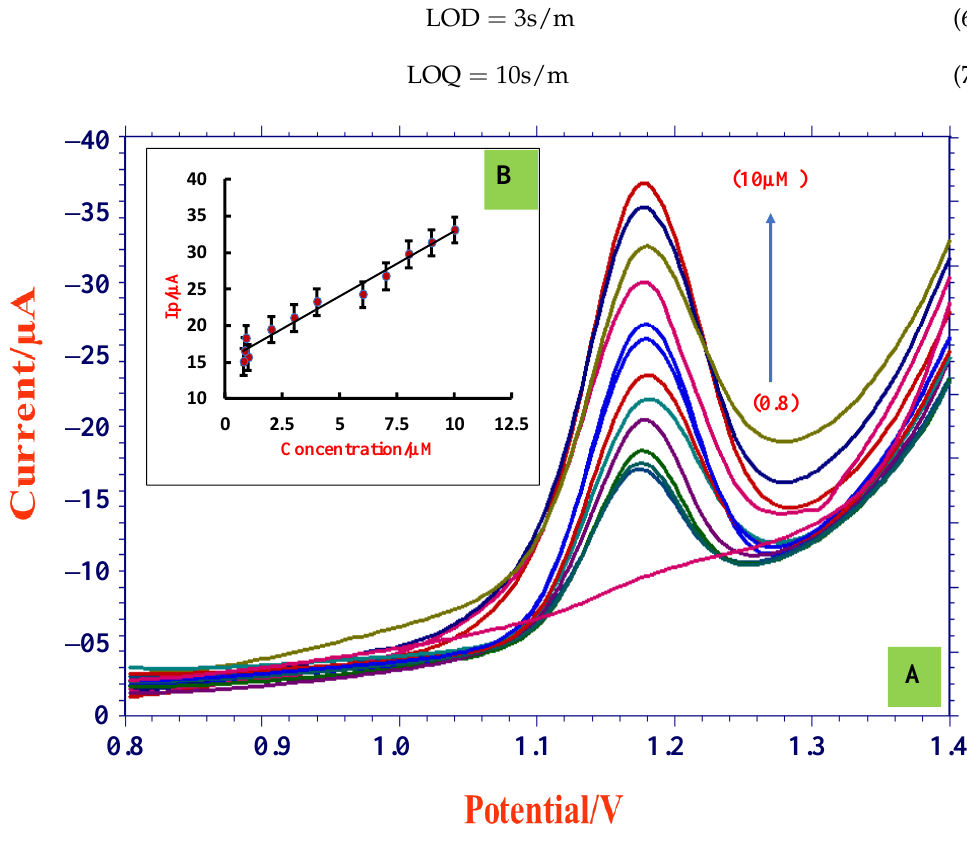
Figure 7. ( A ) DPVs of concentration variation (0.8 µ M–10 µ M) at ZnO/SDS/CPE; ( B ) graph of Ip and concentration. Table 1. Comparative study of detection limit of TMP.